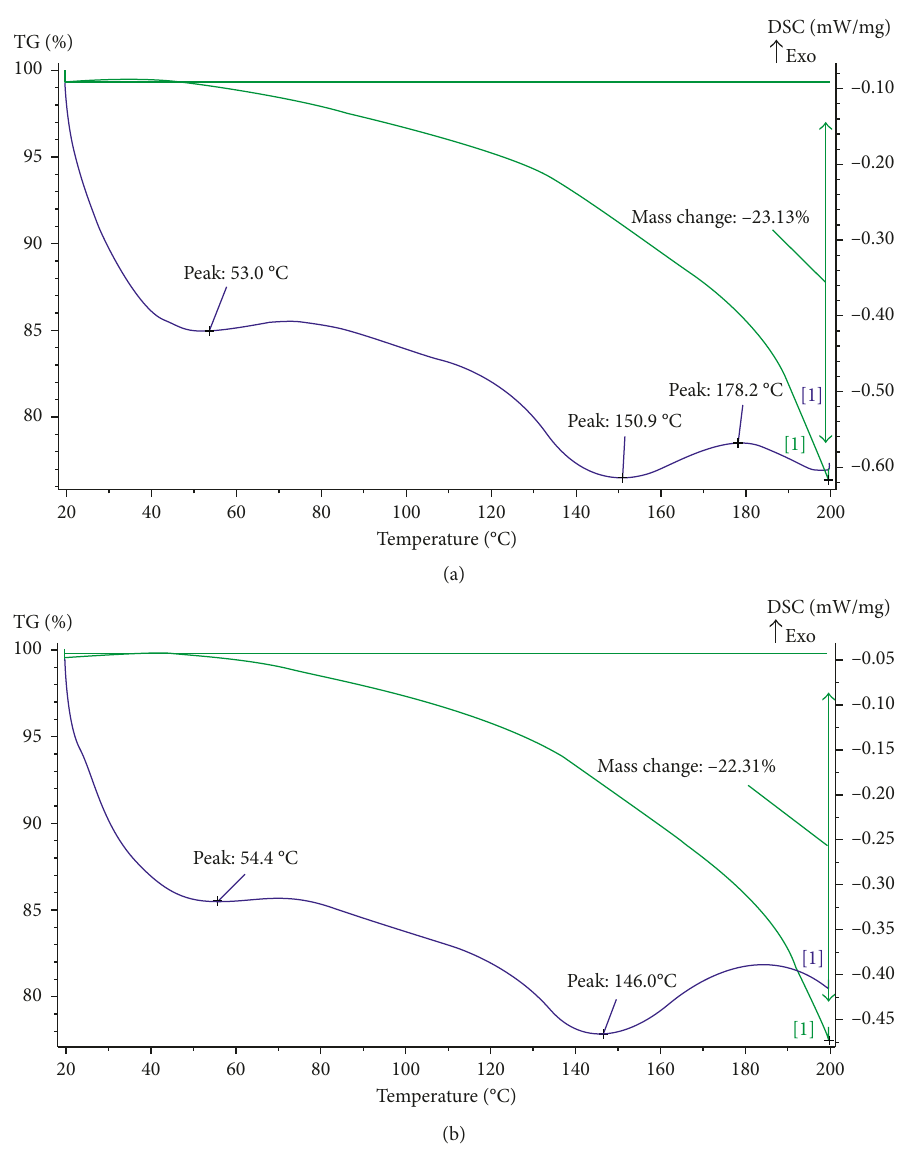
Figure 6: Thermograms of F (a) and G (b) candy samples. See Table 1 for F and G